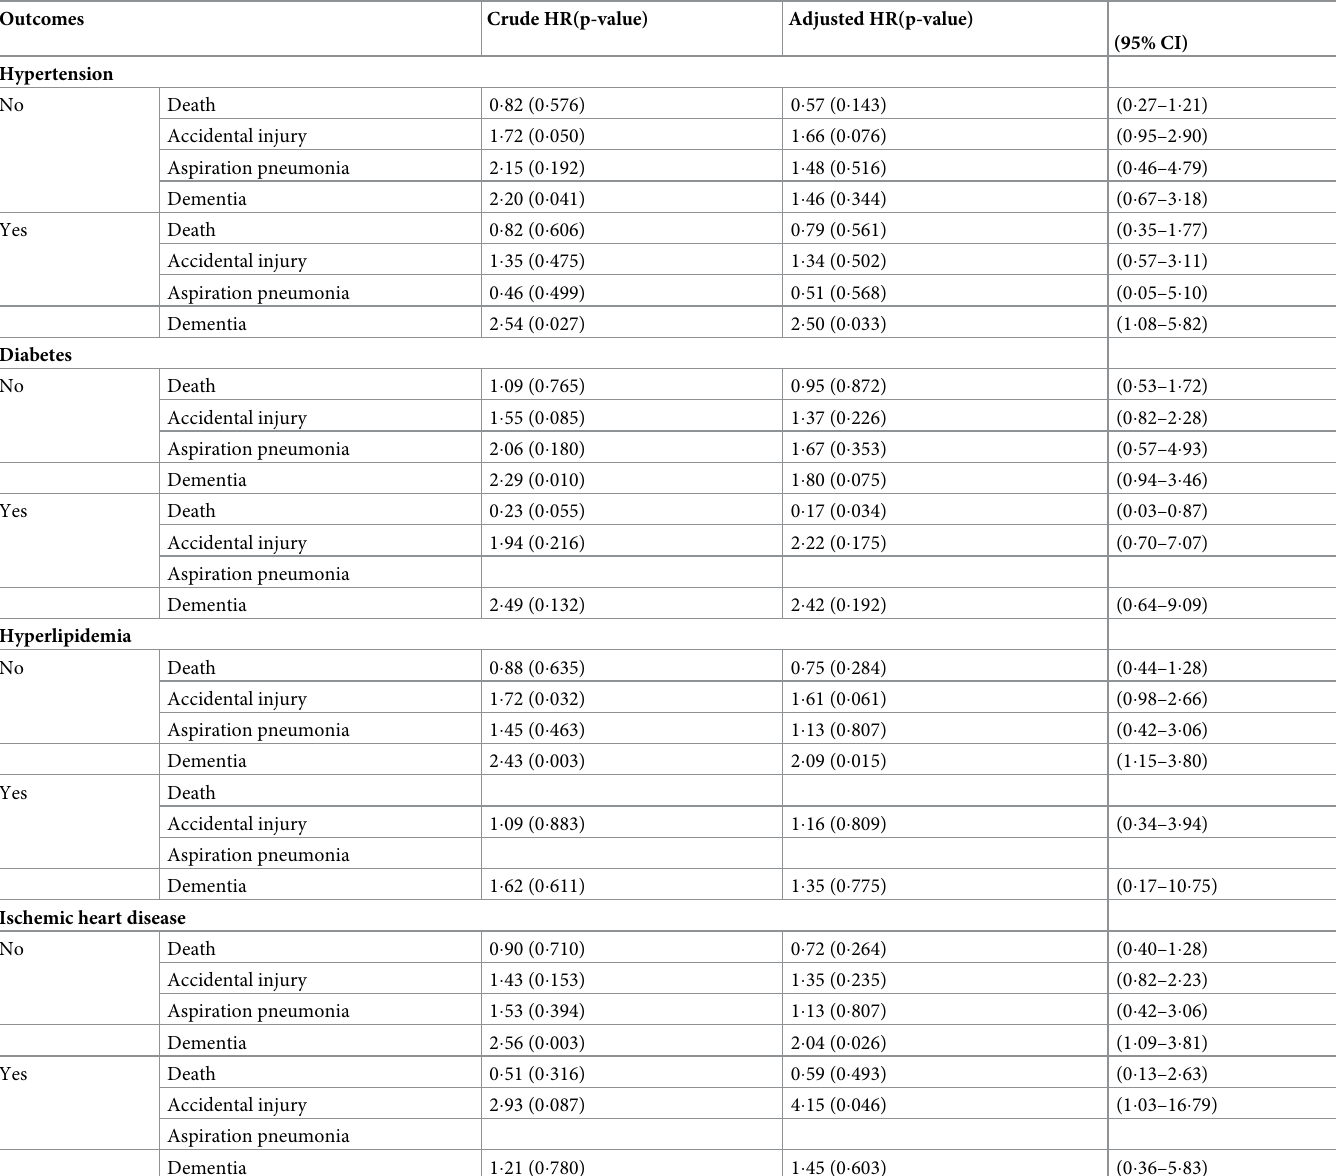
Table 3. Hazard ratio associated with pre-diagnostic and post-diagnostic depression in Cox’s regression analysis, as stratified by